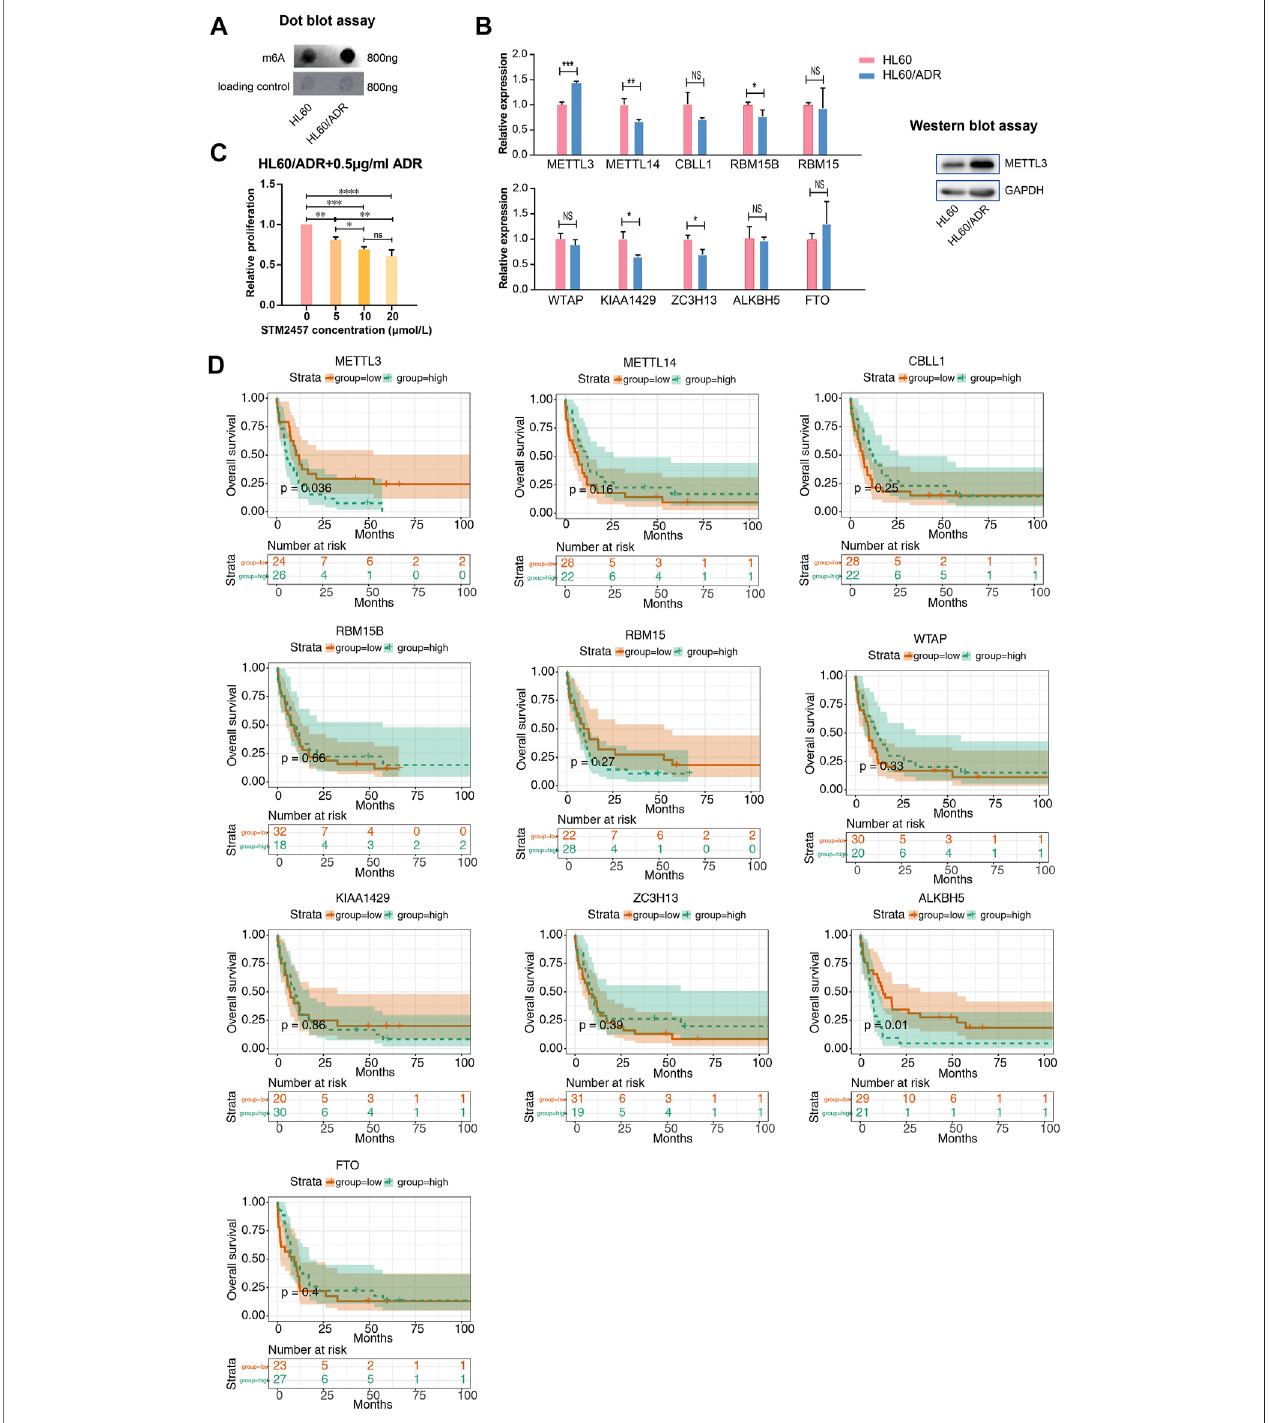
FIGURE 5 | Analysis of the global m 6 A level and m 6 A-related enzymes. (A) Dot blot assay revealed a higher global m 6 A level in HL60/ADR than that in HL60. (B) Analysis of the expression level of ten m 6 A writers and erasers by RT-qPCR in HL60 and HL60/ADR. Western blot assay showed a higher protein level of METTL3 in HL60/ADR cells. * p < 0.05, ** p < 0.01, *** p < 0.001. NS, no signi fi cance. (C) Results of CCK-8 assay after treatment of STM2457 and ADR for three days. NS, no signi fi cance,* p < 0.05,** p < 0.01,*** p < 0.001,**** p < 0.0001.Eachgrouphadthreebiologicalreplicates. (D) Overallsurvivalanalysisoftenm 6 Awritersanderasersin AML